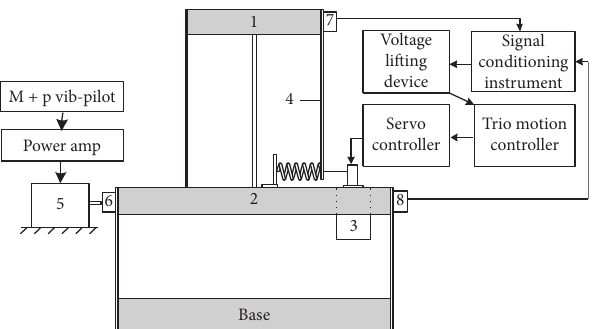
Figure 3: Schematic of time-delayed feedback control (1: absorber mass, 2: primary mass, 3: servo motor, 4: controlled steel sheet, 5: shaker, 6: force sensor, and 7 and 8: acceleration sensors).